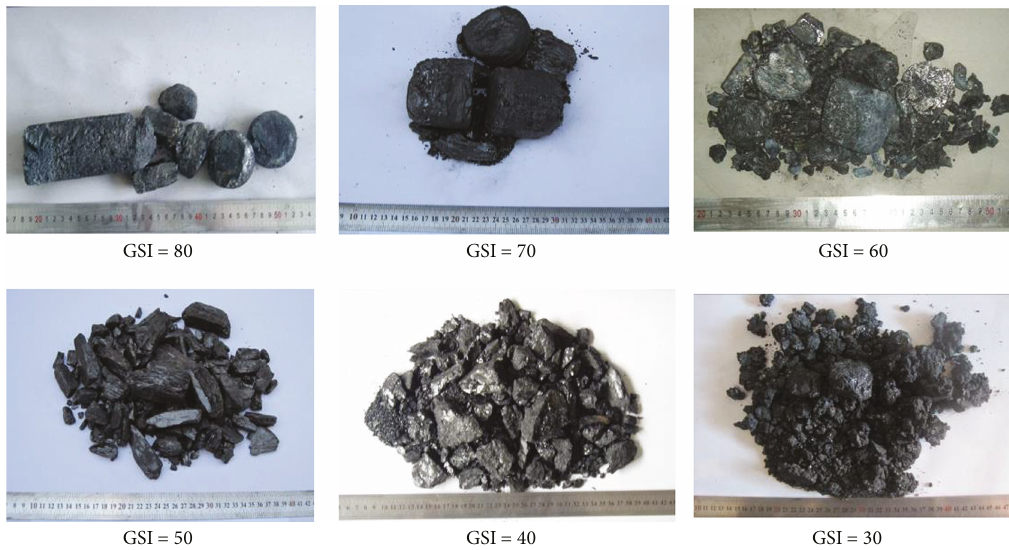
Figure 2: GSI quantisation of coal showing typical deformation in the study area. 100 GSI = 182.93 DEN -187.46